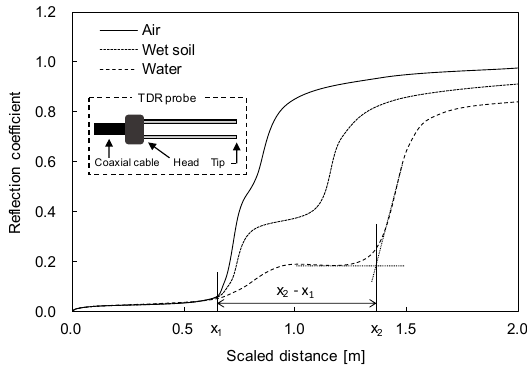
Figure 2. Typical TDR waveforms in air, wet soil, and water.